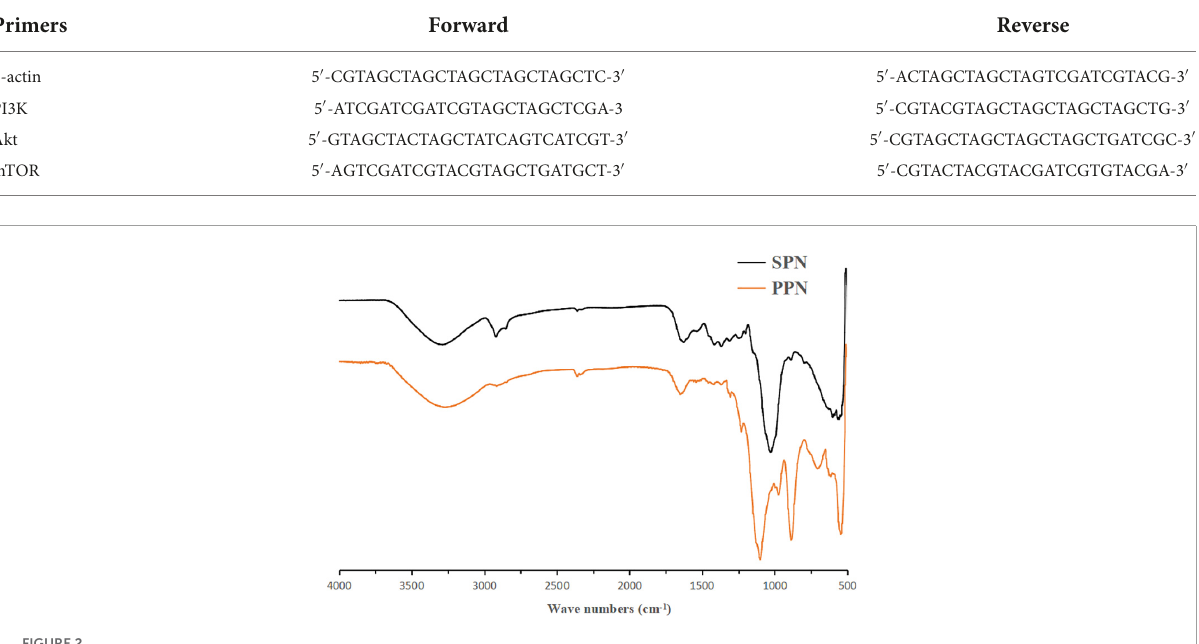
TABLE 1 The primer sequence of real-time PCR.